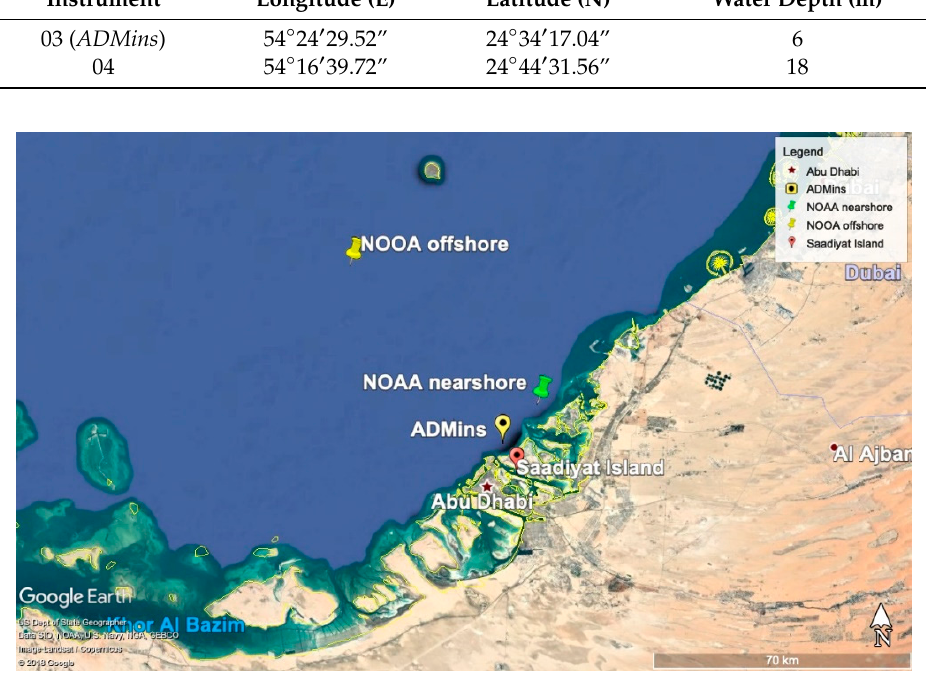
Figure 3. Location of ADMins , and NOAA nearshore and offshore grid points for the wind/wave model data. Table 2. Coordinates of the positions of the two instruments installed by the Abu Dhabi Municipality (ADM) and the relative water depth.